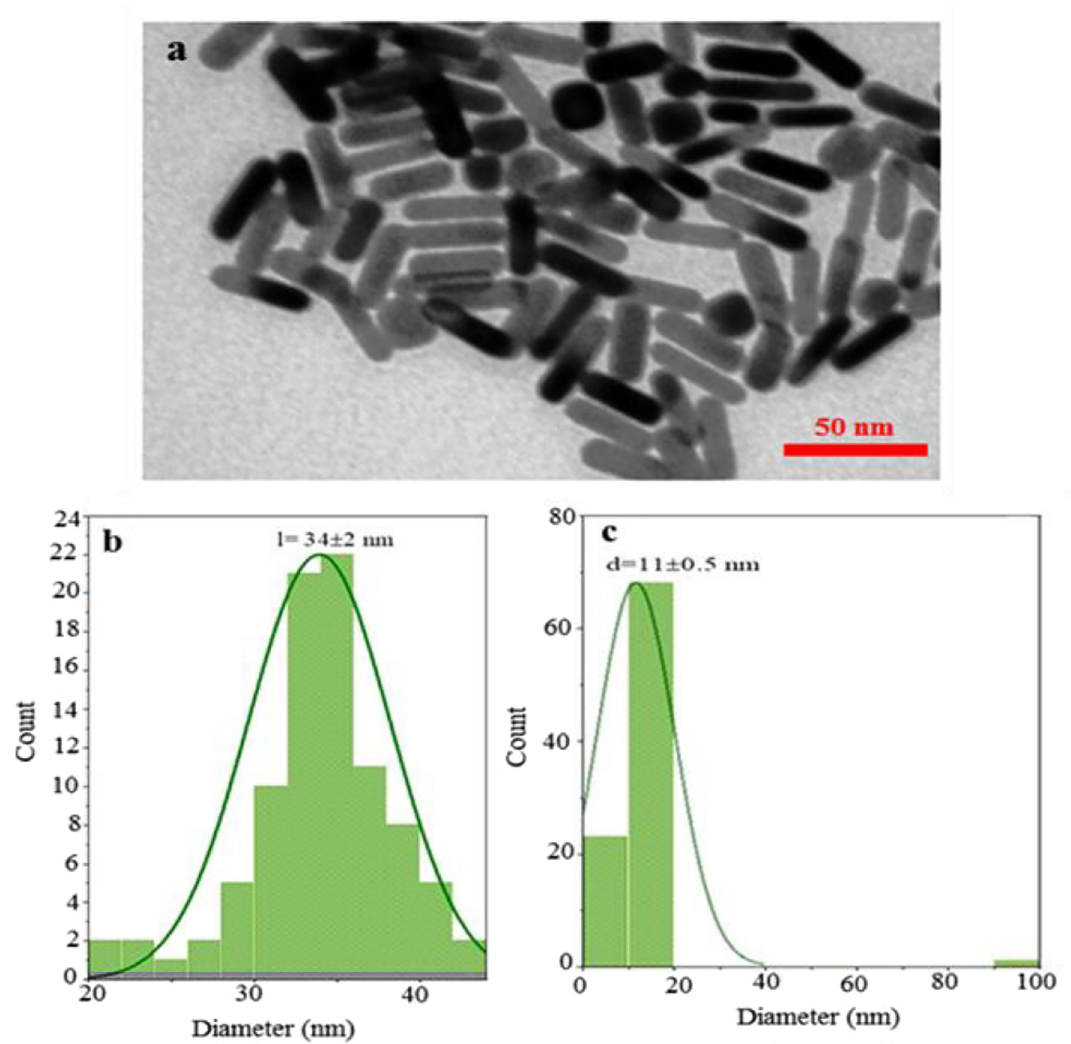
Figure 2: Characterization of the GNRs. (a) TEM image of CTAB-capped GNRs, (b) and (c) Statistical data of the length and the diameter of more than 100 GNRs as shown in (a),